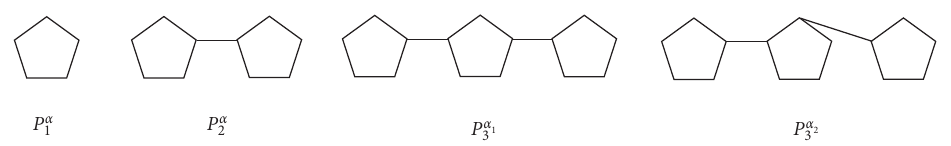
Figure 2: The alpha-pentachains for n � 1 , 2 , 3.